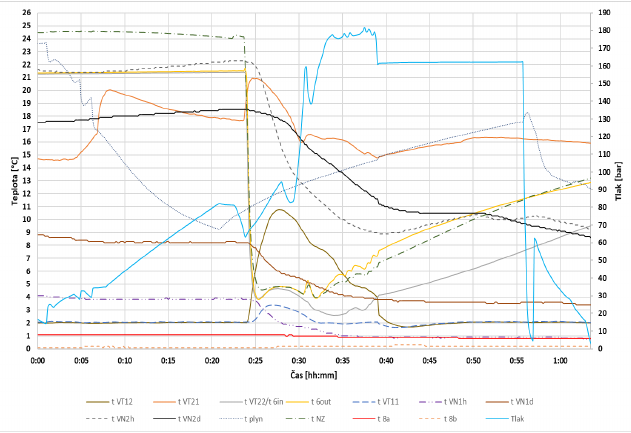
Figure 7. Measured temperature